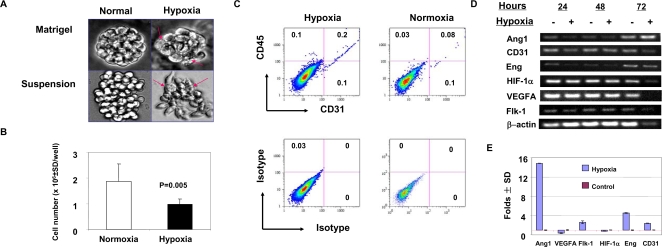
Differentiation of pCSCs in responding to hypoxia.The pCSCs (clone 2C4; 5×104/well) were cultured in 0.5 ml (hypoxia) or 2.0 ml (normoxic) of R10F medium or Matrigel. From day 3∼4 of cultures, the cells in the suspension medium or Matrigel are morphologically altered in the hypoxic culture but not in normoxic cultures (A). The cells were harvested on day 4 of cultures, enumerated (B), and analyzed for CD31 and CD45 expression by flow cytometry (C), or harvested on day 1, 2, 3 and 4 for angiogenic factor expression revealed by RT-PCR (D, day 1∼3) or real-time PCR (E, day 4). A, the phase contrast microphotographs of cell morphology of pCSCs cultured in Matrigel-containing or suspension medium under the normal or hypoxic condition, which were taken at day 4 of culture. Arrows indicate apoptotic cells. B, Hypoxia inhibited proliferation of pCSCs. Data shown are pooled results from two of four reproducible experiments (n = 4 well/group/expt). C, phenotypic analysis of the pCSCs cultured in the hypoxic condition using flow cytometry. The number in each quadrant represents the percentage of the gated live cells. D and E, Expression of vascular growth factor and endothelial cell marker genes in the pCSCs responding to hypoxia. The cells were harvested at day 1, 2, and 3 of cultures and analyzed by RT-PCR (D), or harvested at day 4 and analyzed by real-time PCR (E). Data shown are representatives from 3∼4 experiments, and the data of D was also quantitated and shown in Fig. S3.